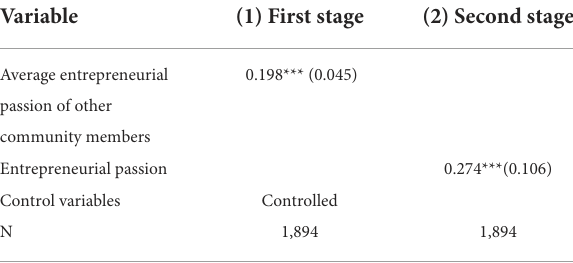
TABLE 12 Instrumental variable testing results (economic